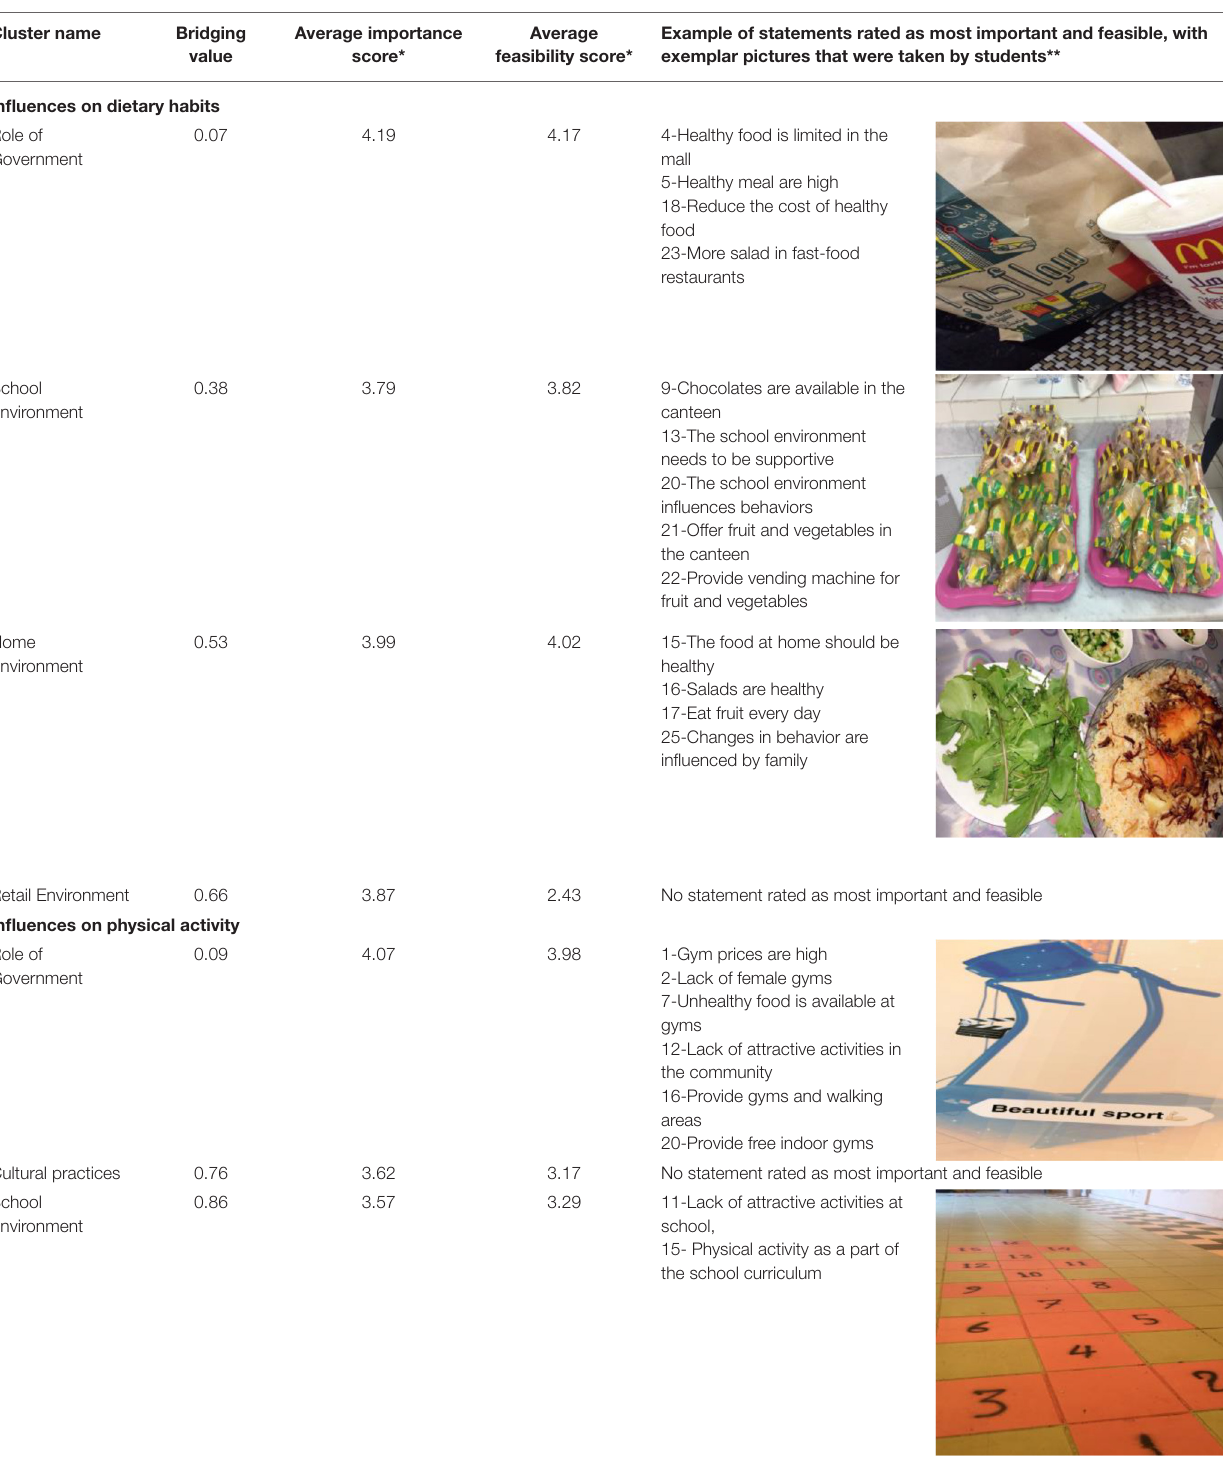
TABLE 1 | Students’ perspectives on factors influencing their dietary habits and physical activity: average bridging values and average ratings for importance and feasibility for each cluster, statements that were rated relatively high for both importance and feasibility (upper right quadrant of the Go-Zone map) and exemplar photographs taken by students to generate statements.